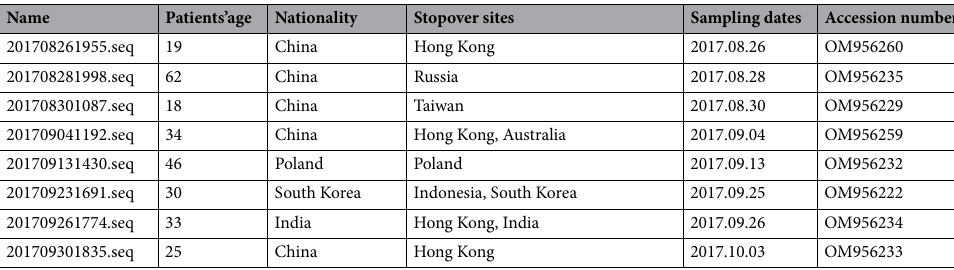
Table 2. Influenza A(H3N2) virus strains sequenced in this